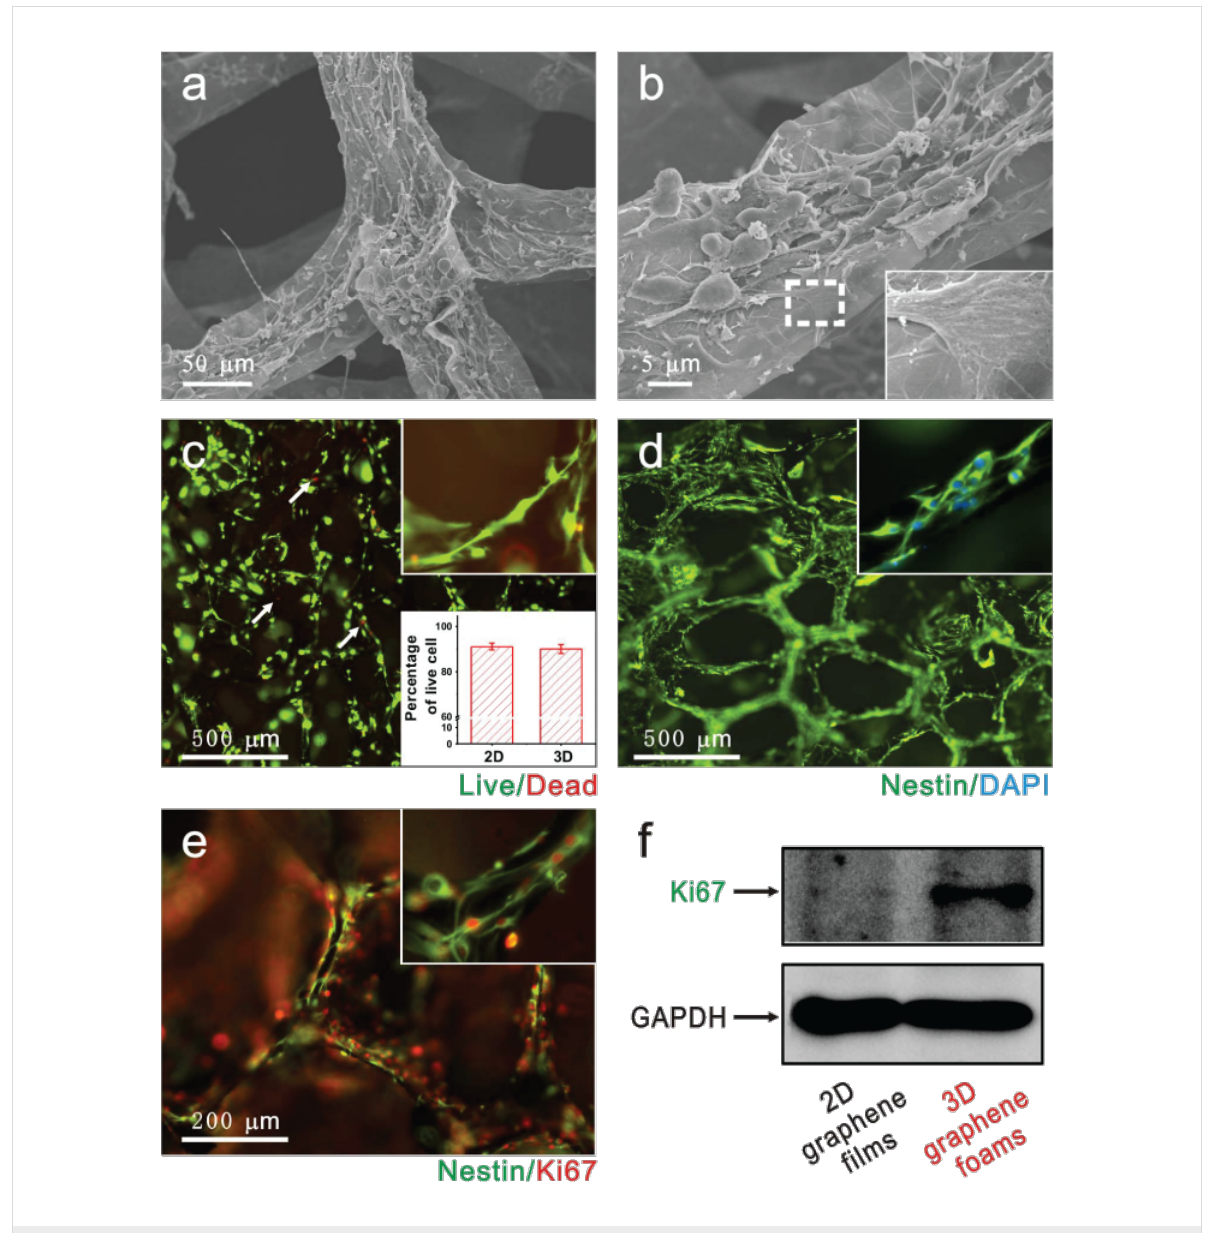
Figure 6: Three-dimensional graphene foam scaffolds allow neural stem cells to adhere and improve their proliferation by up-regulating Ki-67 protein expression. Reproduced from [146] with permission. Copyright 2013 Nature Publishing